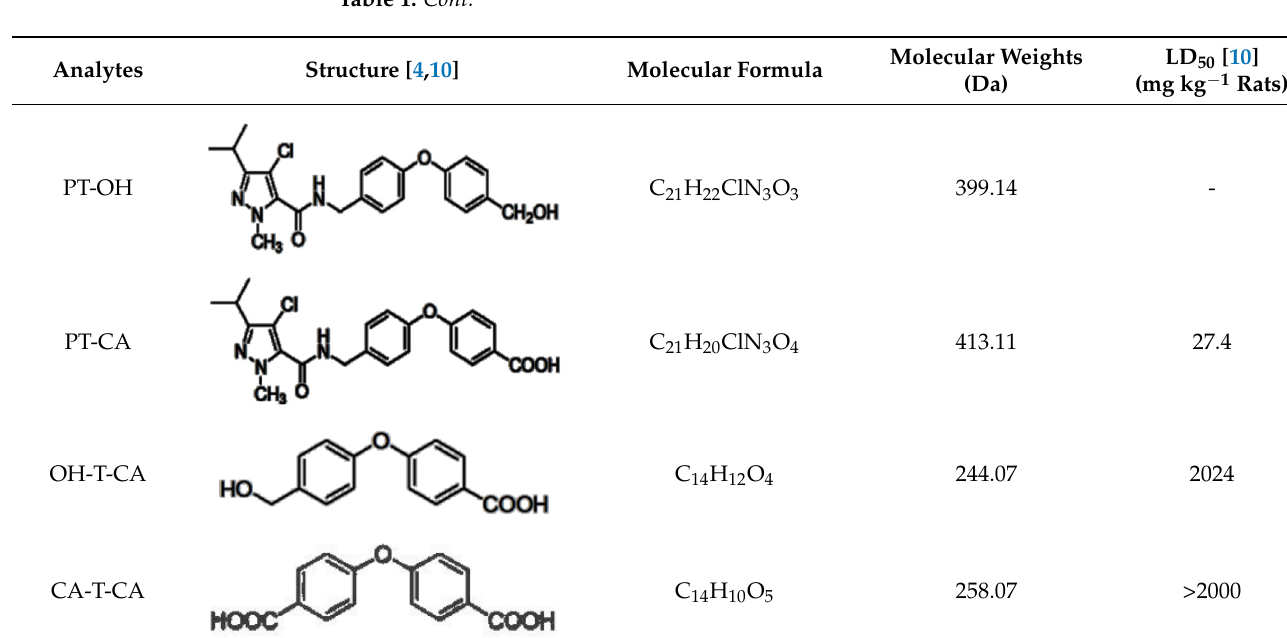
Table 1. The chemical structure and toxicological parameters of TFP and its main